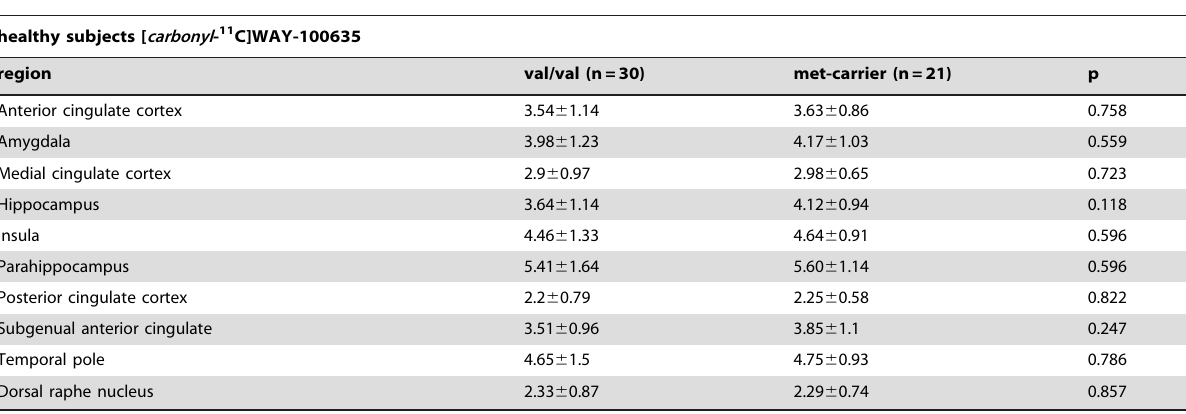
Table 2. Post-hoc t-tests comparing serotonin-1A receptor (5-HT 1A ) binding potential (BP ND ) according to BDNF Val66Met genotype status in 51 healthy subjects.